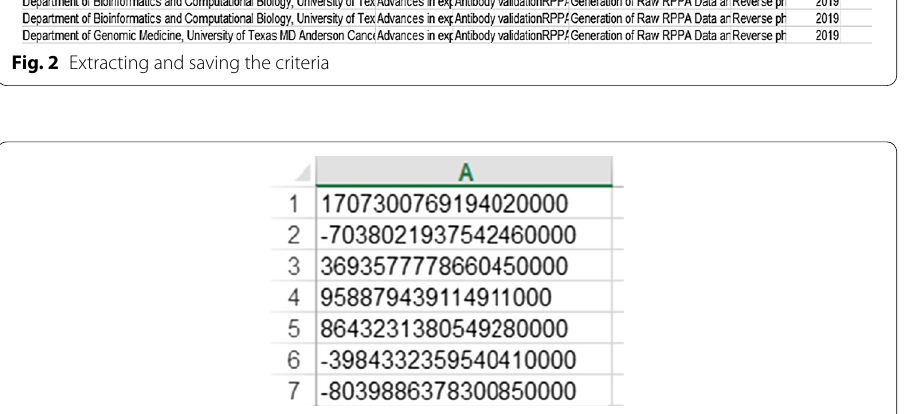
Fig. 3 Converting keys to array indices via the hash